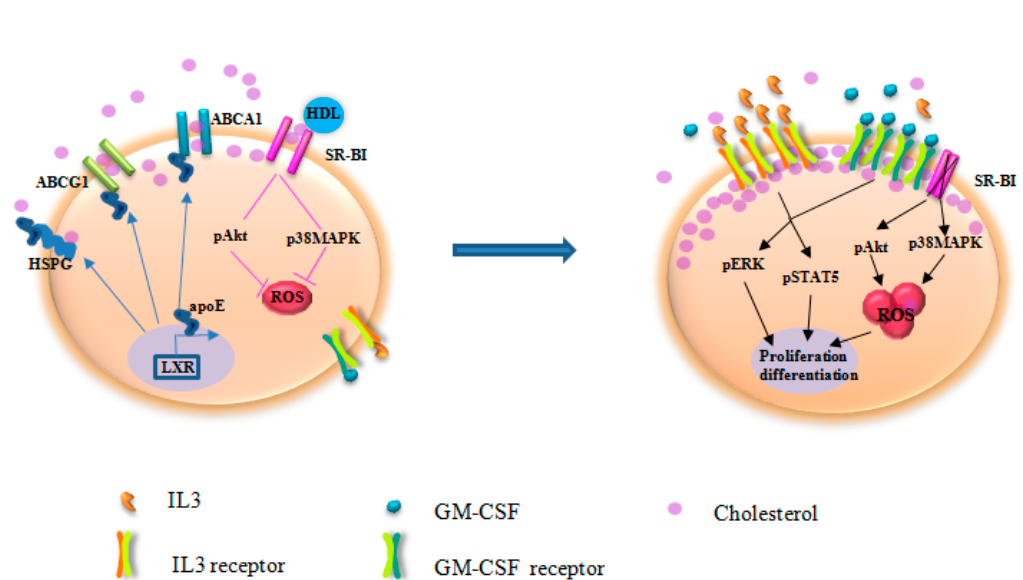
Figure 2. The mechanisms underlying the impact of hypercholesterolemia on HSPC. Under normocholesterolemia, ATP-binding cassette transporter ( ABCA1), ATP-binding cassette sub-family G member 1 ( ABCG1), and scavenger receptor type B-I (SR-BI) facilitate cholesterol efflux. After secretion, apolipoprotein E (apoE) binds to heparin sulfate proteoglycans (HSPG) for cholesterol removal. Furthermore, apoE and apoE-containing HDL interact with ABCA1 and ABCG1 for reverse cholesterol transport. apoE, ABCA1, and ABCG1 expression are regulated by liver X receptor (LXR). HDL acts via SR-BI to control Akt and p38 mitogen-activated protein kinases (p38MAPK) phosphorylation and reactive oxygen species (ROS) production. As the net result, cholesterol homeostasis is maintained in HSPC. Deficiency of ABCA1, ABCG1, apoE, and SR-BI disrupts cholesterol efflux. Hypercholesterolemia accelerates impaired cholesterol efflux, leading to enriched cholesterol accumulation in the lipid raft. Thus, the expression of the common β subunit of the IL-3/GM-CSF receptors is increased, resulting in elevated response to IL-3 and GM-CSF for HSPC proliferation. In parallel, SR-BI deficiency abrogates the regulation of HDL on ROS production. Therefore, HSPC are activated for proliferation and differentiation. The skewed HSPC differentiation to myeloid cells produces IL-3 and GM-CSF that further potentiate HSPC activation. pERK, phosphorylated extracellular signal-regulated kinase; pSTAT5, phosphorylated signal transducer and activator of transcription 5.